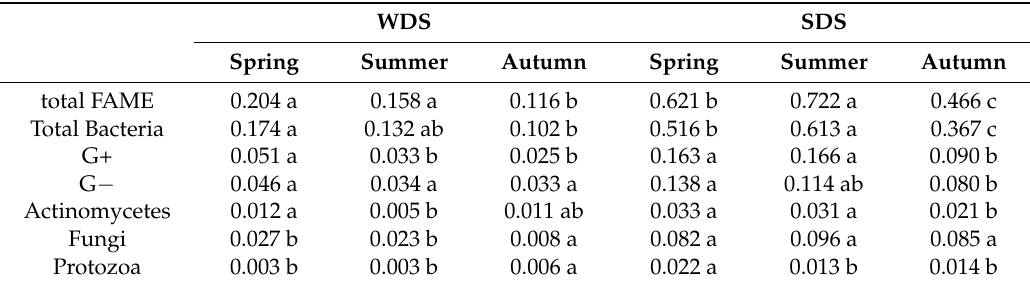
Table 3. Content of EL-FAME (nmol g − 1 soil) along the seasons in winter deciduous (WDS) and summer deciduous (SDS) sites. Different lowercase letters mean significant ( p < 0.05) temporal variation in each group.